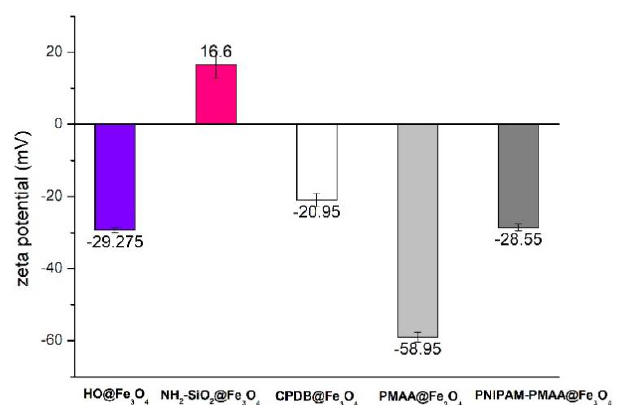
Figure 3 . Zeta-potential analysis of HO@Fe 3 O 4 , NH 2 -SiO 2 @Fe 3 O 4 , CPDB@Fe 3 O 4 , PMAA@Fe 3 O 4 , and PNIPAM-PMAA@Fe 3 O 4 in dd-H 2 O.